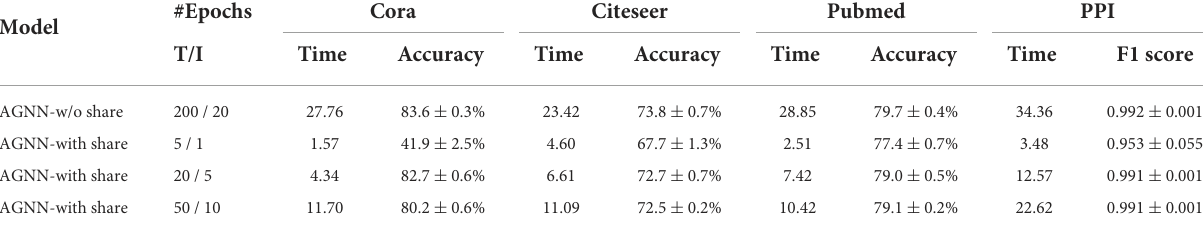
TABLE 5 The trade-off between node classification performance and computation time cost for AGNN.